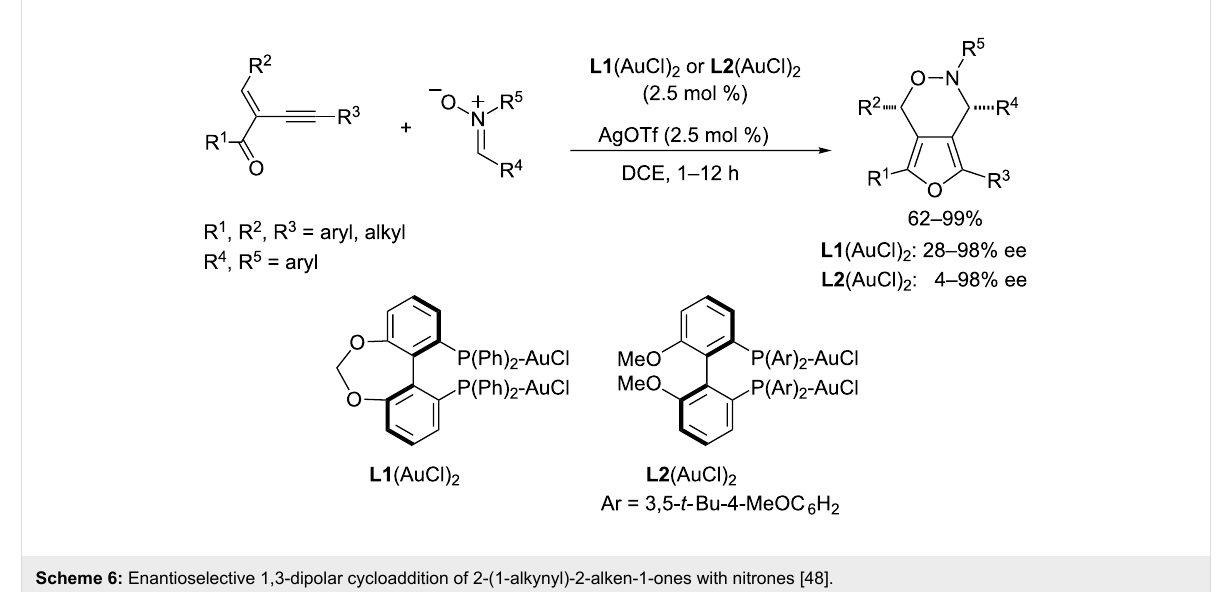
Scheme 6: Enantioselective 1,3-dipolar cycloaddition of 2-(1-alkynyl)-2-alken-1-ones with nitrones [48].